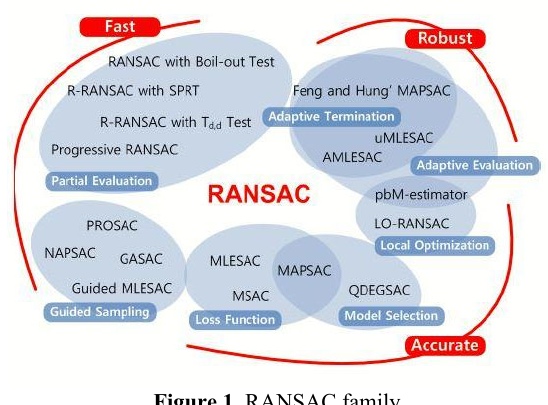
Figure 1. RANSAC family